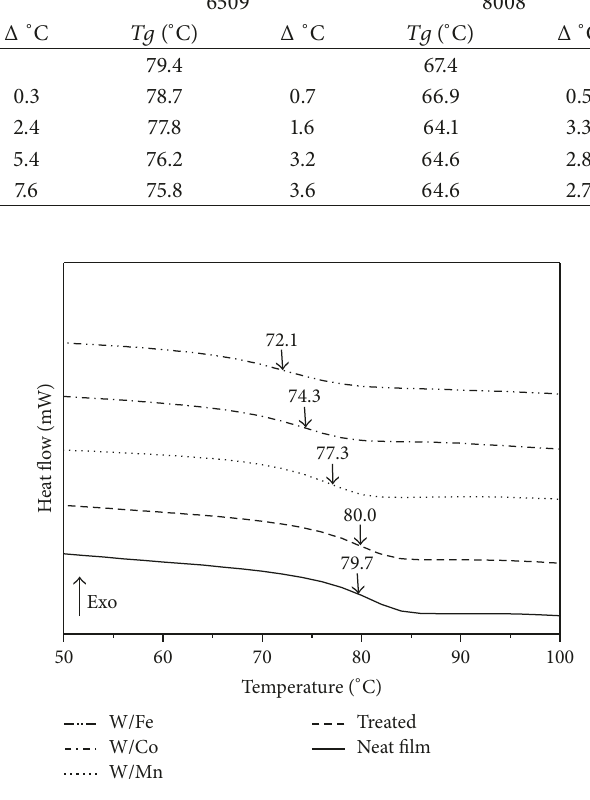
Figure 20: DSC traces of the Topas COC 8007 neat and formulated films with POA after 30 days of aging under